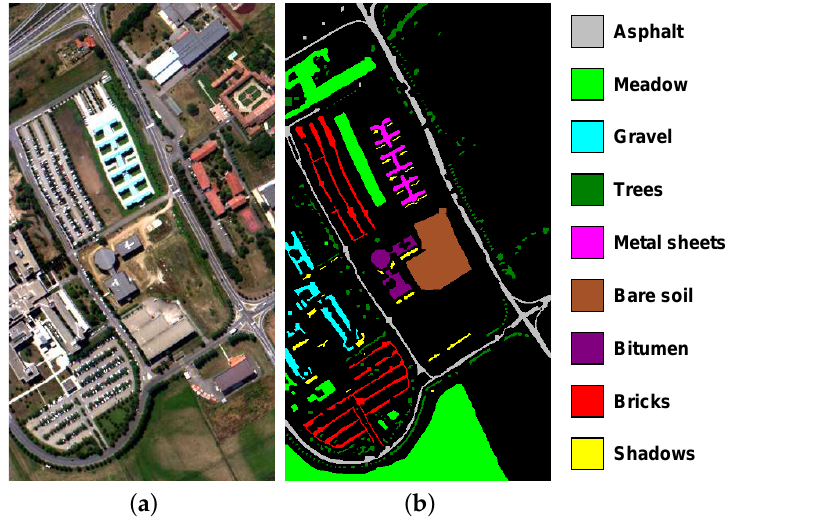
Figure 3. Reflective Optics System Imaging Spectrometer (ROSIS) University of Pavia dataset. ( a ) RGB composite image of three bands. ( b ) Ground-truth map.